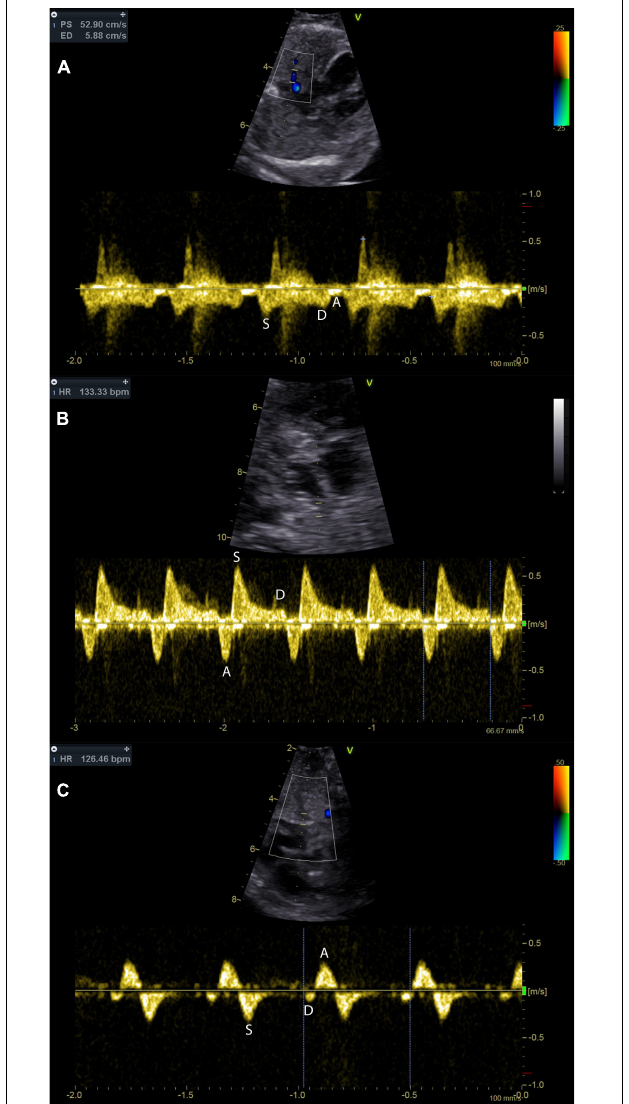
FIGURE 5 | Pulmonary vein Doppler patterns in the hypoplastic left heart with incremental restriction of the interatrial communication. Panel (A) shows a fetus with CAS and an unrestrictive interatrial communication; note that there is reduced flow during atrial systole (A-wave). Panel (B) shows a fetus with HLHS and restrictive, but patent atrial septum. Prominent A-wave flow reversal during atrial systole may be indicative of relevant restriction. Panel (C) shows the pulmonary venous flow pattern in a fetus with HLHS and intact atrial septum. Diastolic pulmonary vein flow is almost